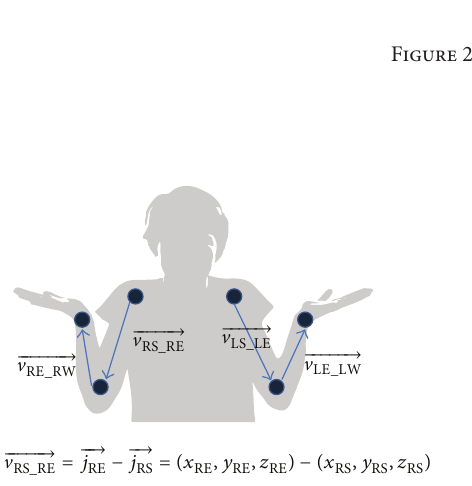
Figure 2: The preprocessing step.